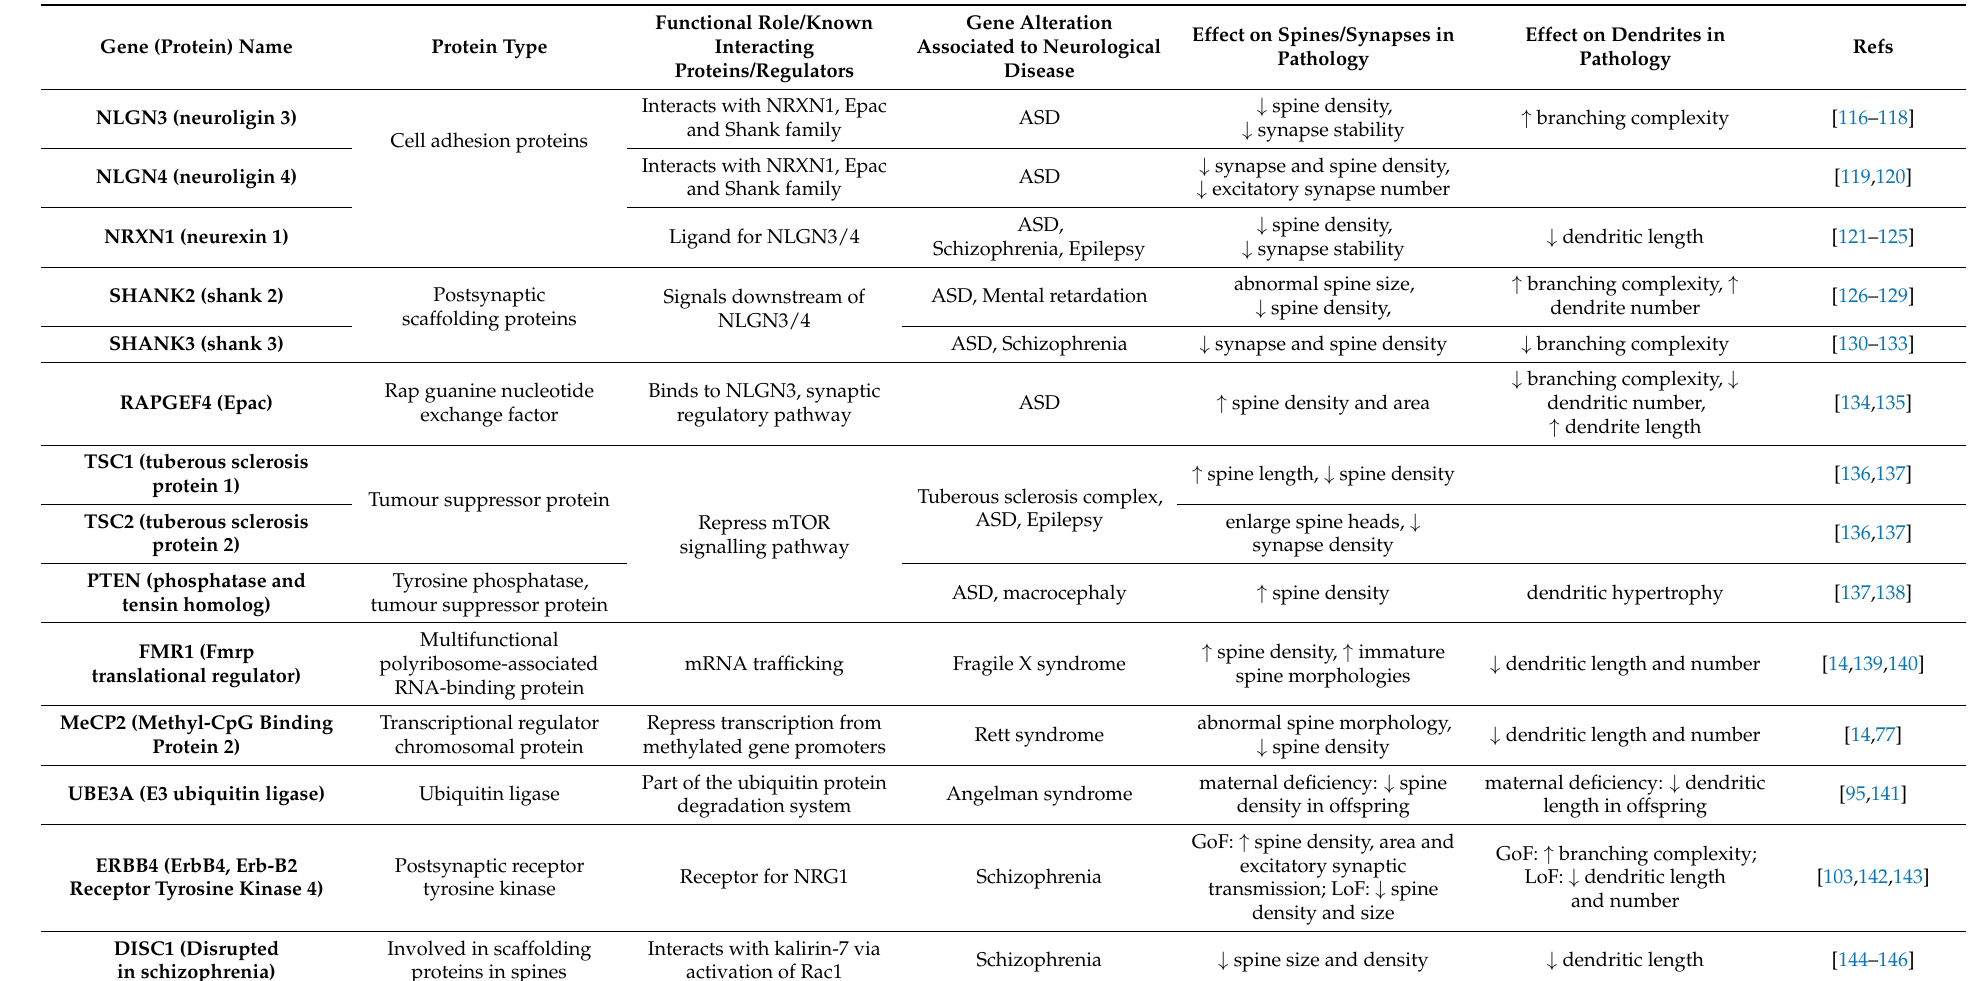
Table 2. Genes (and proteins) that confer risk for neurodevelopmental and degenerative disorders. Information summarises the known interaction pathways and downstream effects on dendritic arborisation and spine